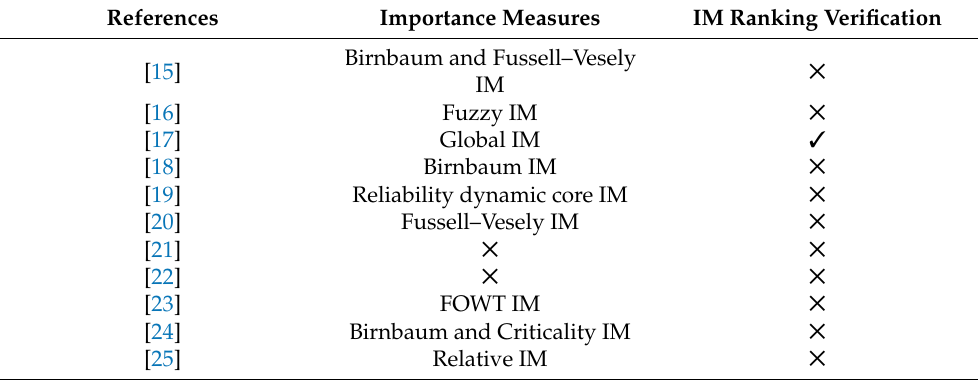
Table 1. Research status comparison of IM-based fault tree analysis